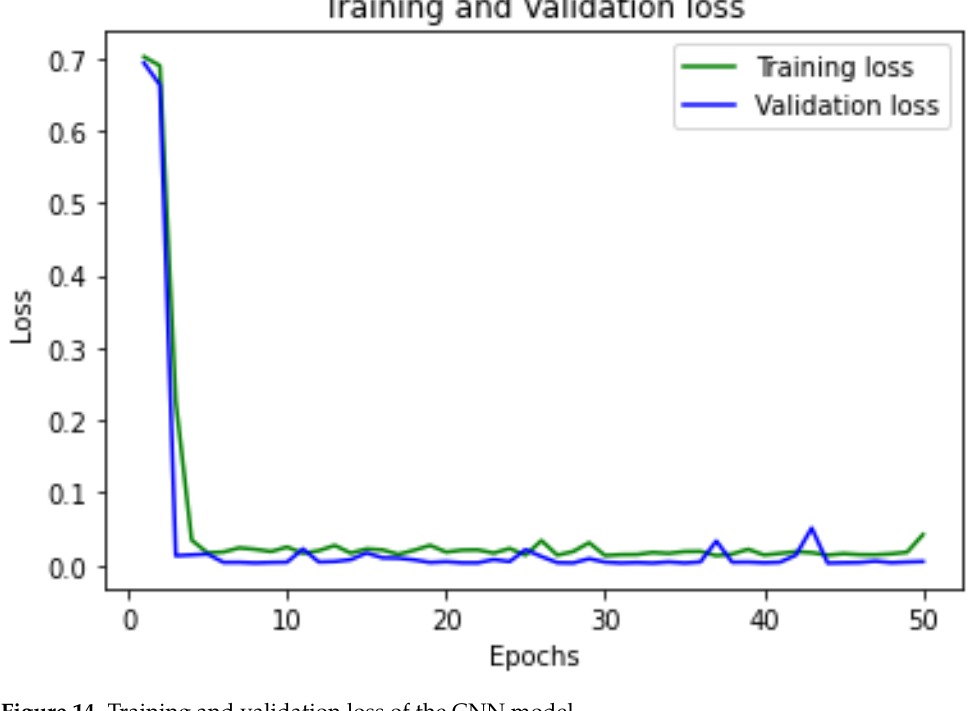
Figure 14. Training and validation loss of the CNN model. Table 1. Model accuracy